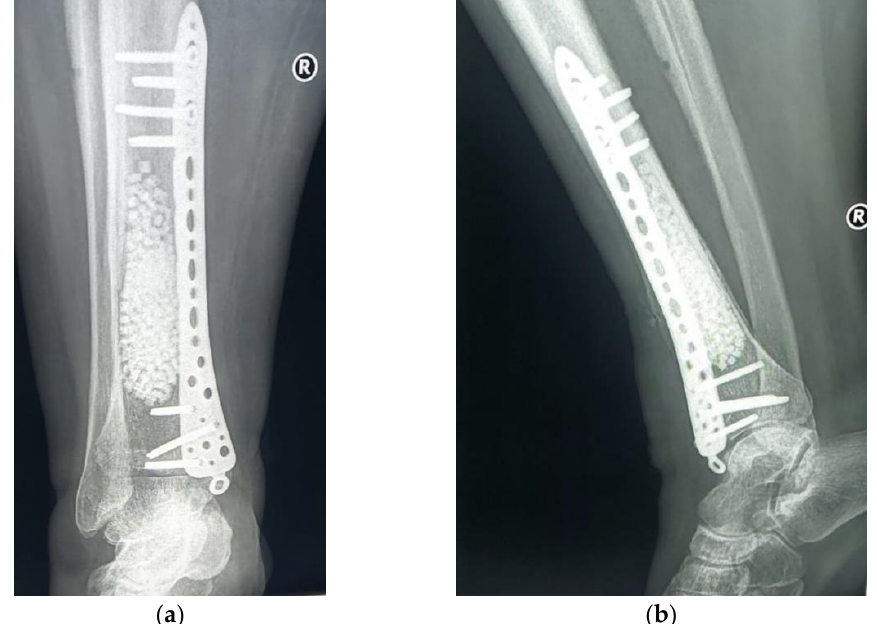
Figure 12. Radiological 6-month follow-up: ( a ) coronal view; ( b ) lateral view.